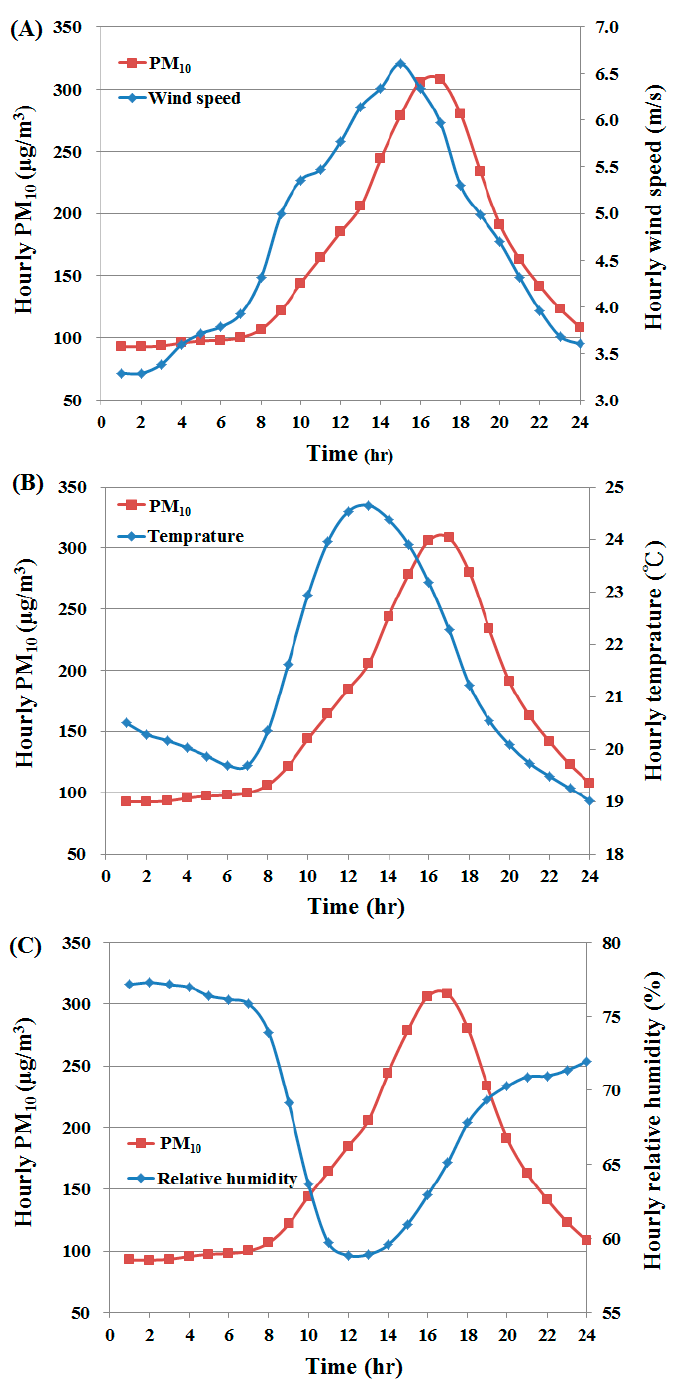
Figure 7. Hourly PM 10 for a day of river dust occurrence with corresponding meteorological data: ( A ) wind velocity; ( B ) temperature; ( C ) relative humidity.